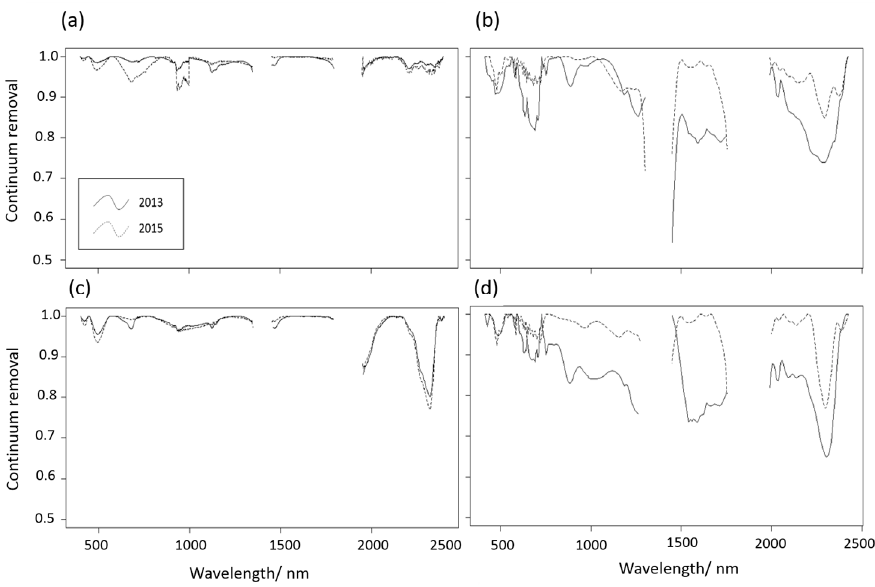
Figure 9. Spectral comparison between Analytical Spectral Devices (ASD) ( a , c ) and APEX ( b , d ) measurements acquired on dark ( a , b ), and bright ( c , d ), reference surfaces in the loam belt area in 2013 and 2015.